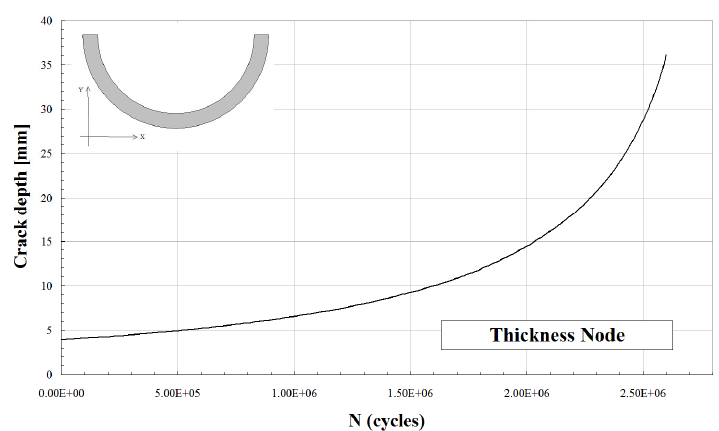
Figure 16: a vs . N for thickness node